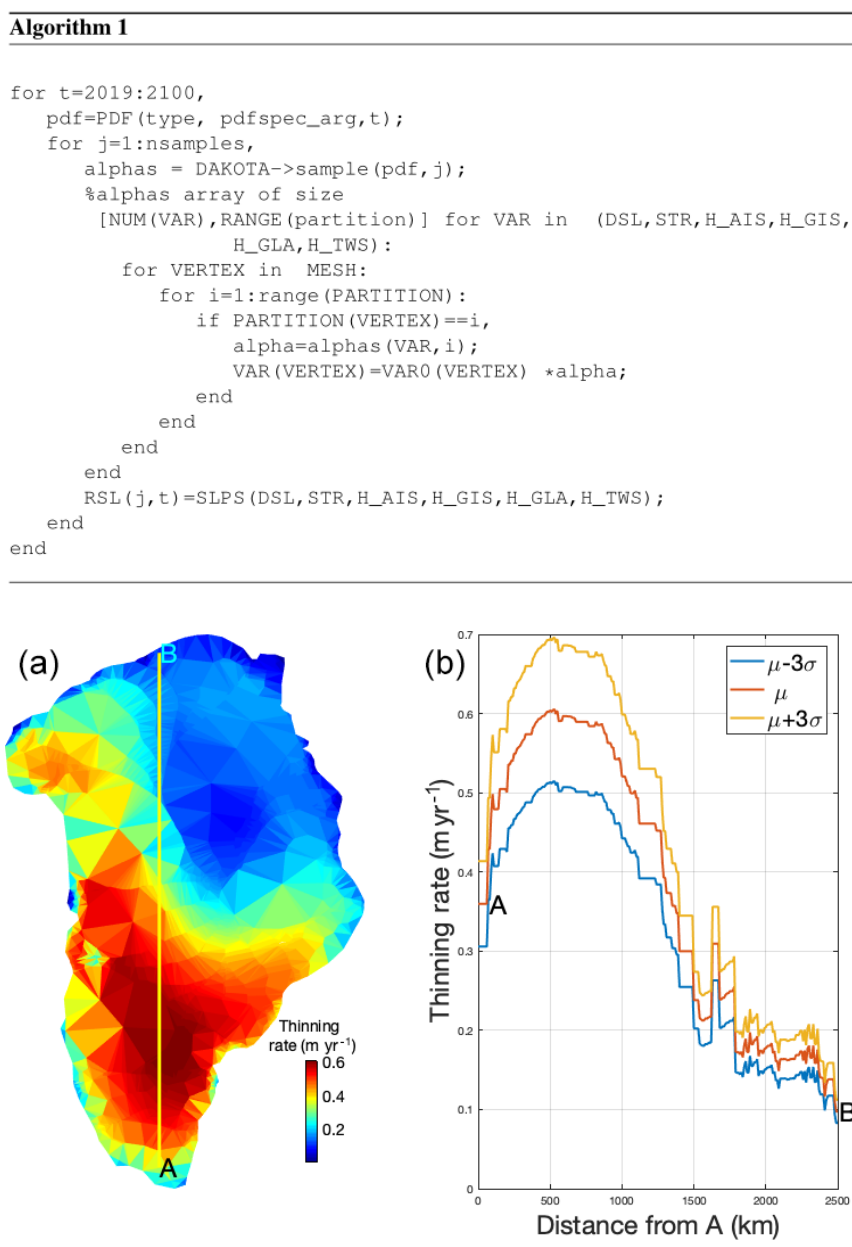
Figure 8. Random sampling of thinning rates across Greenland. (a) GRACE-generated thinning rate pattern at 2005 (in myr − 1 ). (b) Thinning rate along the AB profile (from a ) (in red, representing the average of the PDF) and samples generated at − 3 σ (blue) and + 3 σ (yellow) from the